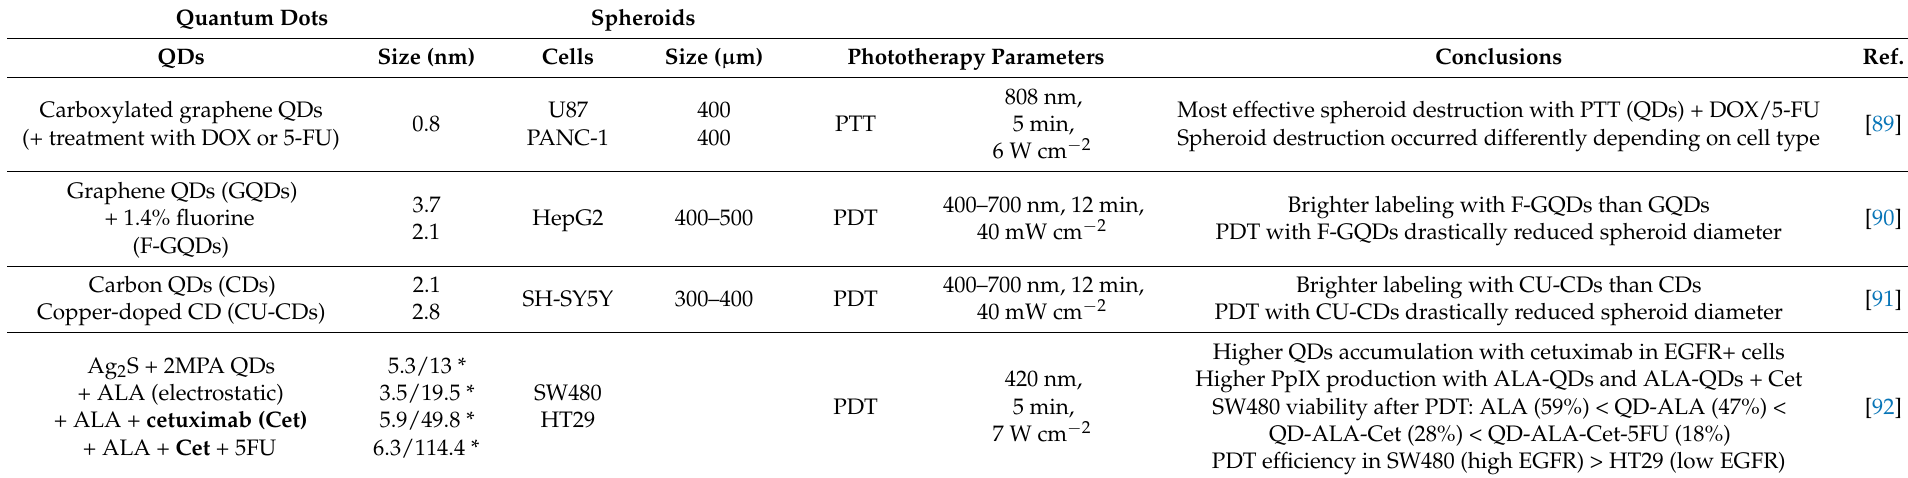
Table 2. Main parameters and conclusions reported using QDs as PDT/PTT agents in spheroid